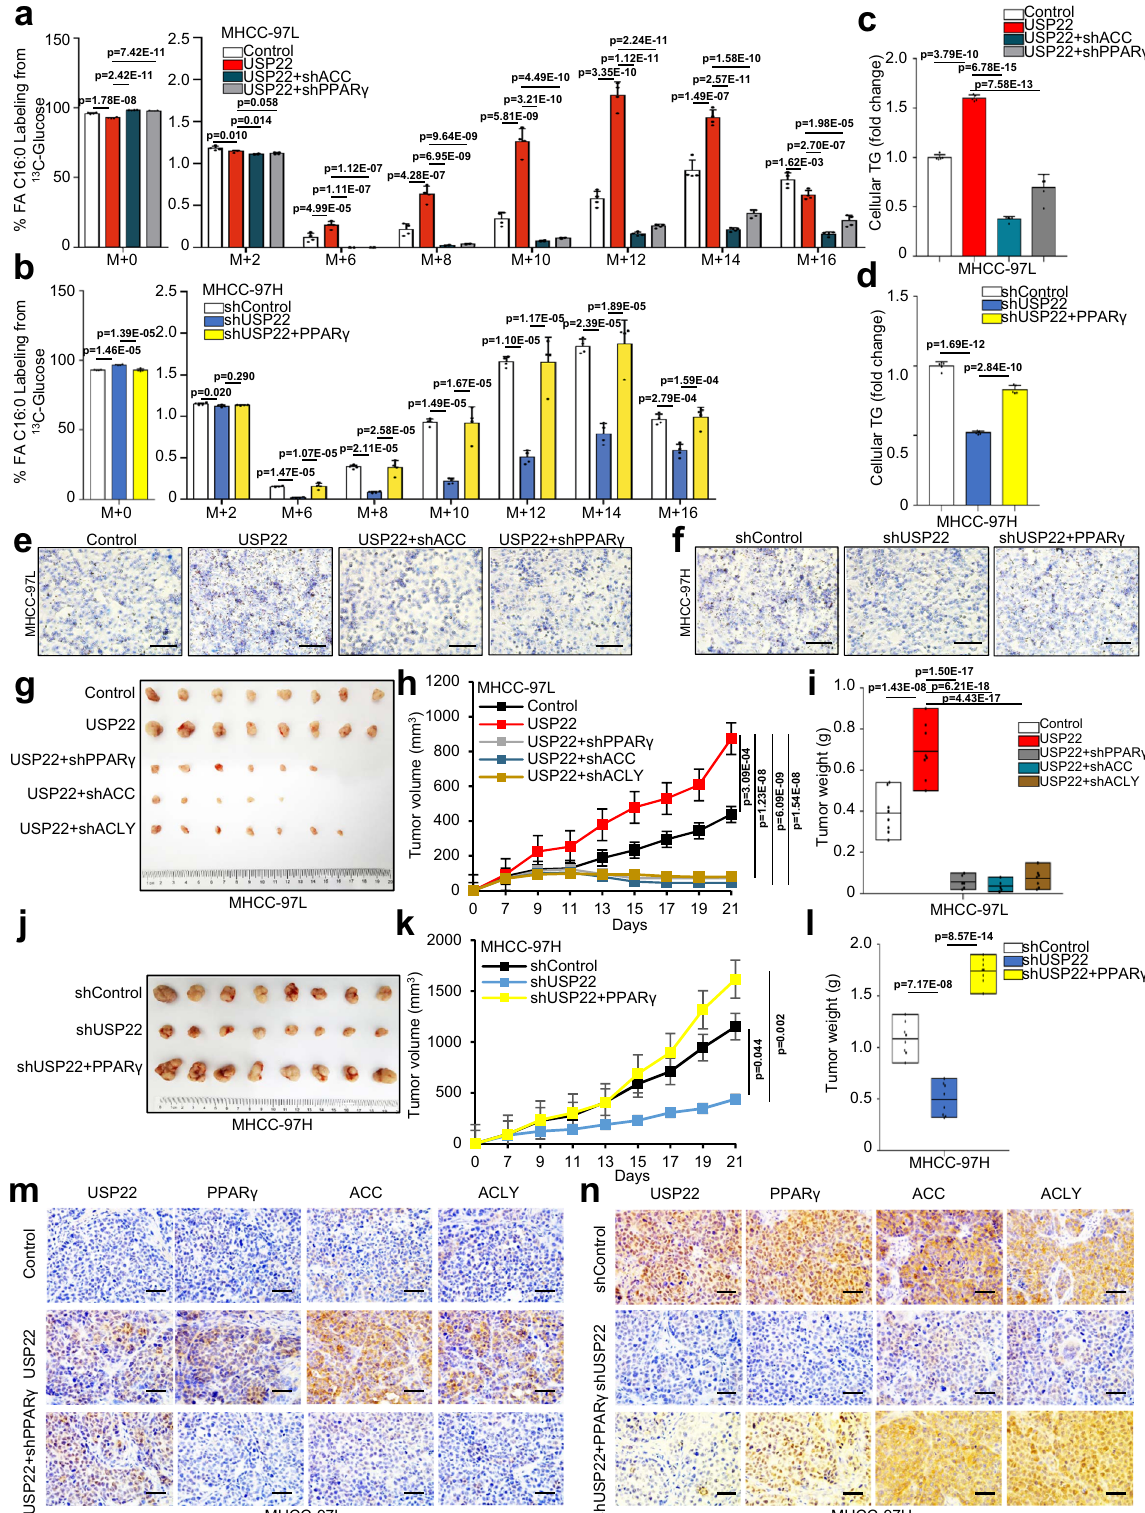
pGL4.16 vector (Promega). A sequence containing nucleotides − 662 nt to − 482 nt luciferase activity obtained from each sample was normalized to the Renilla luci- from ACC promoter was also cloned into pGL4.16 as negative control. The con- ferase activity from the same sample. The PPRE-Luc vector was transfected with structed pGL vector was transfected into HEK293T cells with/without PPAR γ SFB-PPAR γ or SFB-PPAR γ and Myc-USP22. Cells were harvested after 24h and expression plasmid and luciferase activity was measured and analyzed as above. luciferase activity was measured by BioTek Cytation 5. For determination of PPAR γ binding region on ACACA and ACLY promoters, the genomic fragment − 488 nt to − 331 nt from ACLY promoter and fragment − 992 nt to − 757 nt from Triglyceride detection assay . TG was measured with Triglyceride Quanti fi cation ACACA promoter containing predicted PPRE were ampli fi ed and cloned into Assay Kit (Solarbio, BC0625). 5× 10 6 cells were collected and then added 1 ml NATURE COMMUNICATIONS| (2022) 13:2187